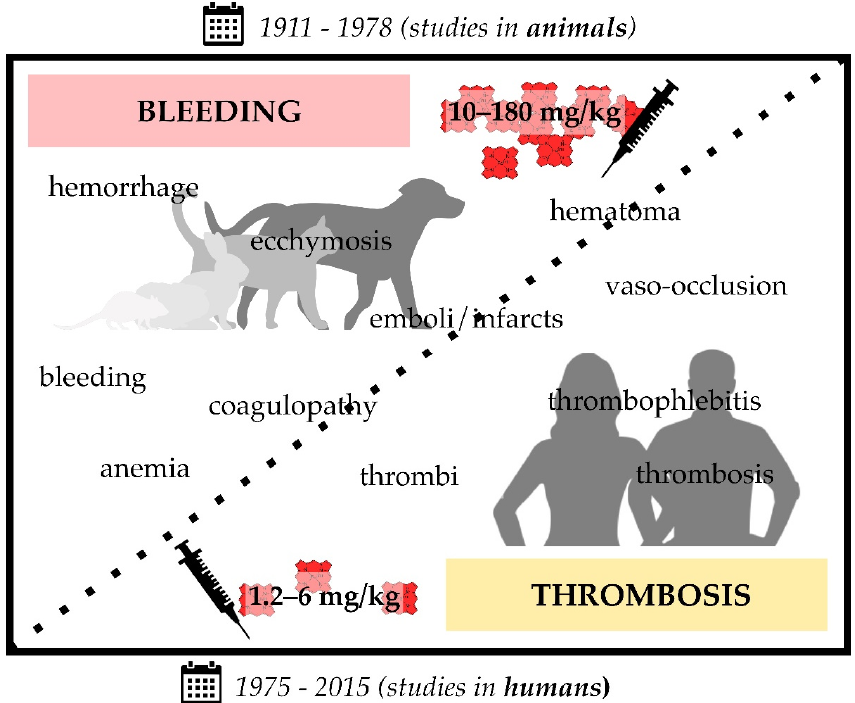
Figure 1. Infusion of heme in different formulations (i.e., hematin, hemin, heme arginate (Normosang ® ), Panhematin ® ) leads to coagulation disorders in animals (1911–1978; rats, guinea pigs, rabbits, cats, and dogs) and humans (1975–2015). Heme infusions of rather high concentrations (10–180 mg/kg) were shown to cause bleeding symptoms in animals, such as hemorrhage and coagulopathy, whereas administration of comparatively low concentrations (1.2–6 mg/kg) resulted in prothrombotic symptoms, such as vaso-occlusion and thrombophlebitis. The transition between bleeding and thrombotic events seems to be smooth, since there are also studies that report both effects in the same study (10–25 mg/kg hematin) [141,143]. Moreover, there are single exceptions (three studies) that also report bleeding upon administration of lower hematin (3.5–9 mg/kg) [140,162] or heme arginate (2–3 mg/kg) [168]